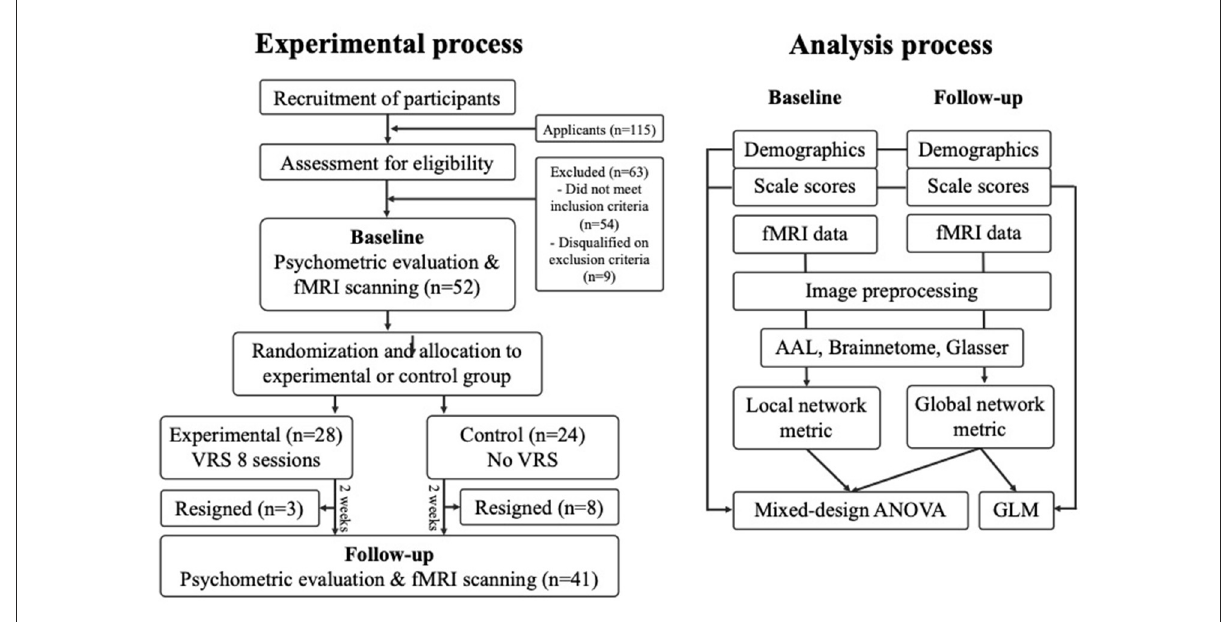
FIGURE1 Flow chart of the experimental